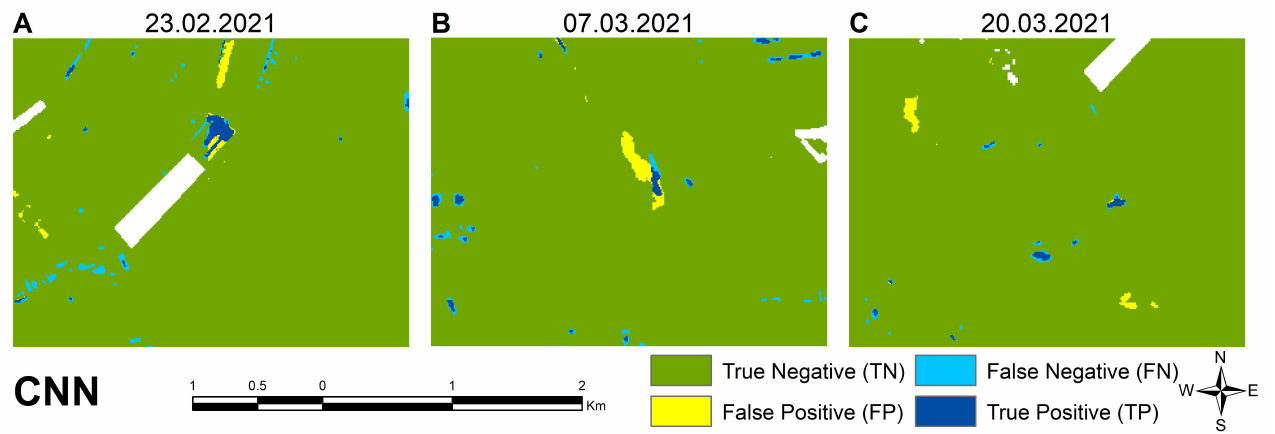
Figure 16. Examples of convolutional neural network model classification errors at different times, including ( A ): Omissions of water detection 23 February 2021; ( B ): some overclassification 7 March 2021; and ( C ): some overclassification and minor omissions 20 March 2021. Table 1. Statistical comparison of methods for the first acquisition date.